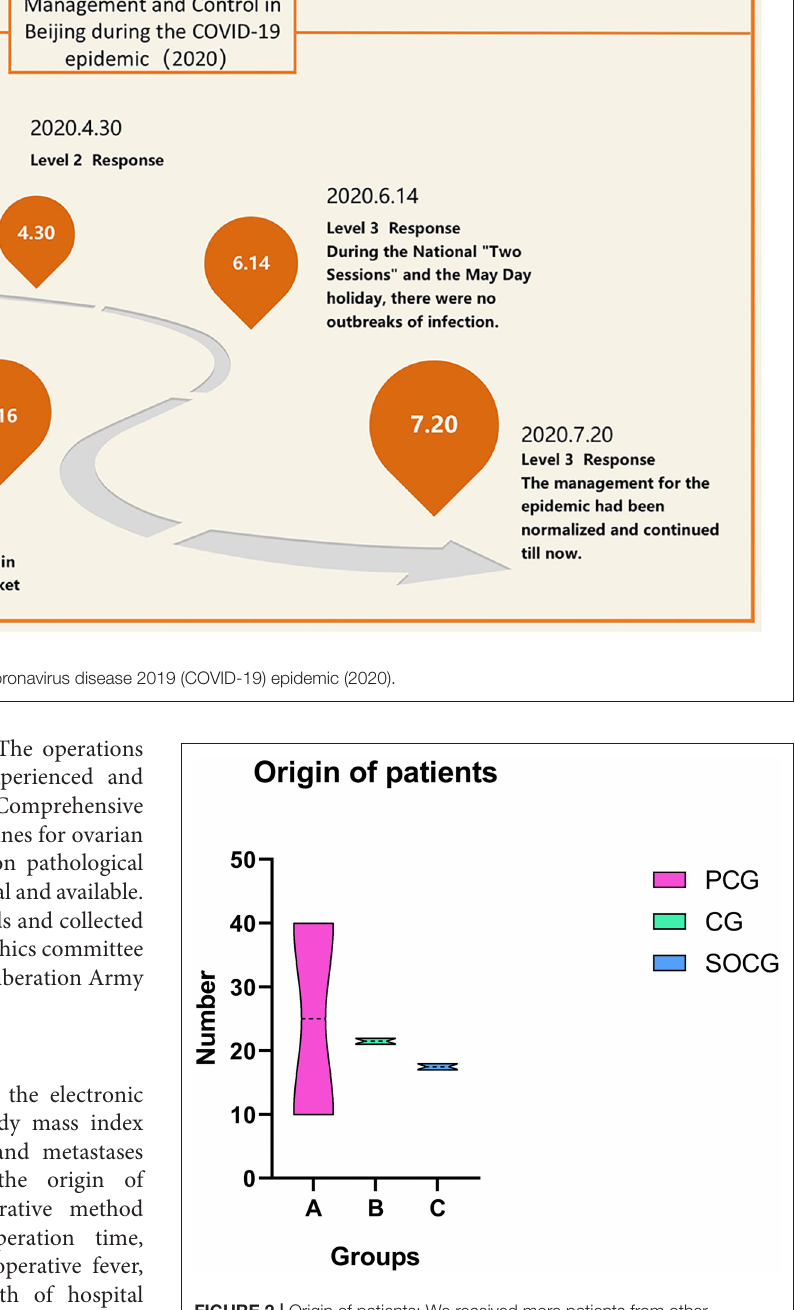
The comparison between the groups used Tukey’s